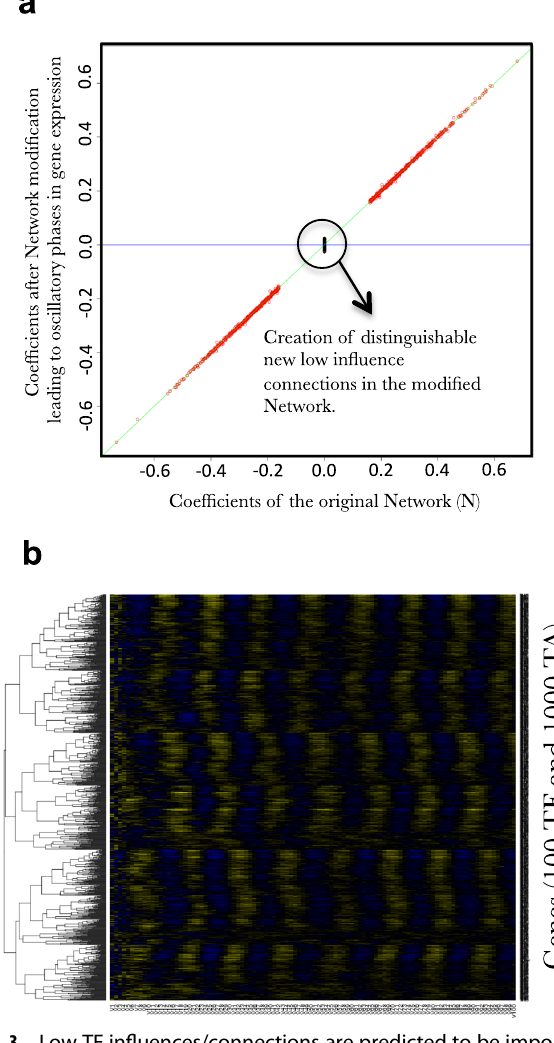
Fig. 3 Low TF in fl uences/connections are predicted to be important to drive network expression oscillations. a Plot of the coef fi cient values of the matrix N (the network) before ( x -axis) and after ( y -axis) modi fi cation (see text) to force 3 Eigen values to be on the unit circle the other one being inside it. b Simulated gene expression across 100 iterations ( E 0 to E 100 ) of a FRANK simulated network (100 TF, 1000 TA) displays oscillatory